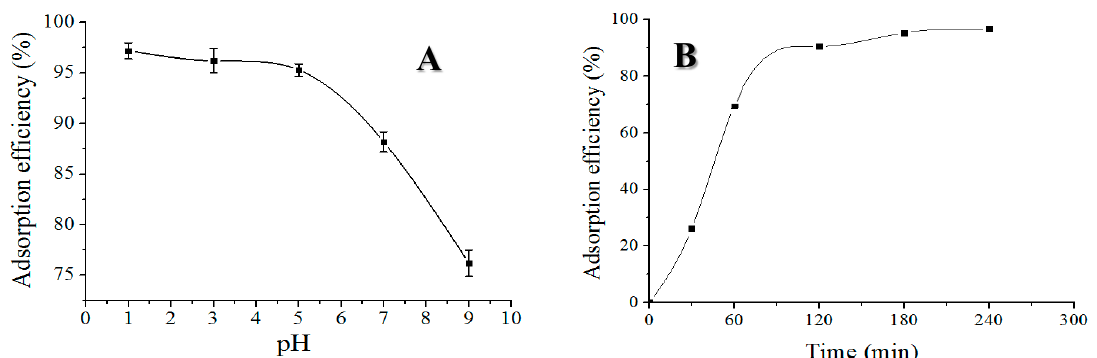
Figure 8. ( A ) E ff ect of pH value on adsorption performance of CS / GO aerogel. ( B ) E ff ect of adsorption Figure 8. ( A ) Effect of pH value on adsorption performance of CS/GO aerogel. ( B ) Effect of adsorption time on adsorption performance of the CS/GO aerogel. time on adsorption performance of the CS / GO